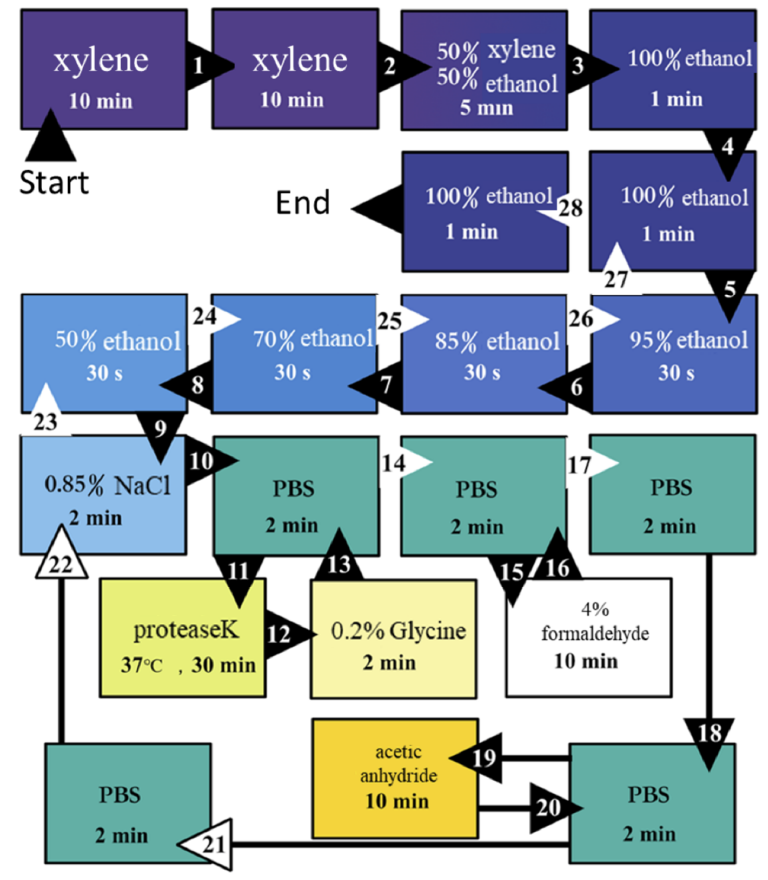
Figure 5. Schematic process of the optimized hybridization pretreatment.